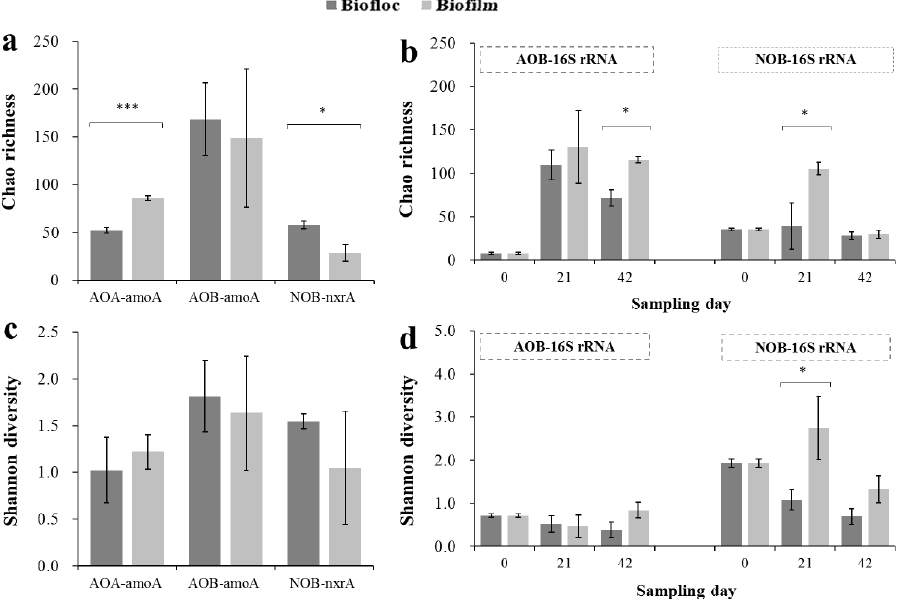
Figure 5. Alpha-diversity comparison of nitrifying microbial communities based on Miseq sequencing of 16S rRNA and functional genes between biofloc and biofilm from the hybrid biofloc-RAS for shrimp intensive culture in a 70-day trial (mean ± S.D., N = 3; * p < 0.05; *** p < 0.001). ( a ) Chao richness of AOA- amo A, AOB- amo A and NOB- nxr A at day 42; ( b ) Chao richness of AOB-16S rRNA and NOB-16S rRNA at day 0, 21 and 42; ( c ) Shannon diversity of AOA- amo A, AOB- amo A and NOB- nxr A at day 42; ( d ) Shannon diversity of AOB-16S rRNA and NOB-16S rRNA at day 0, 21 and 42.